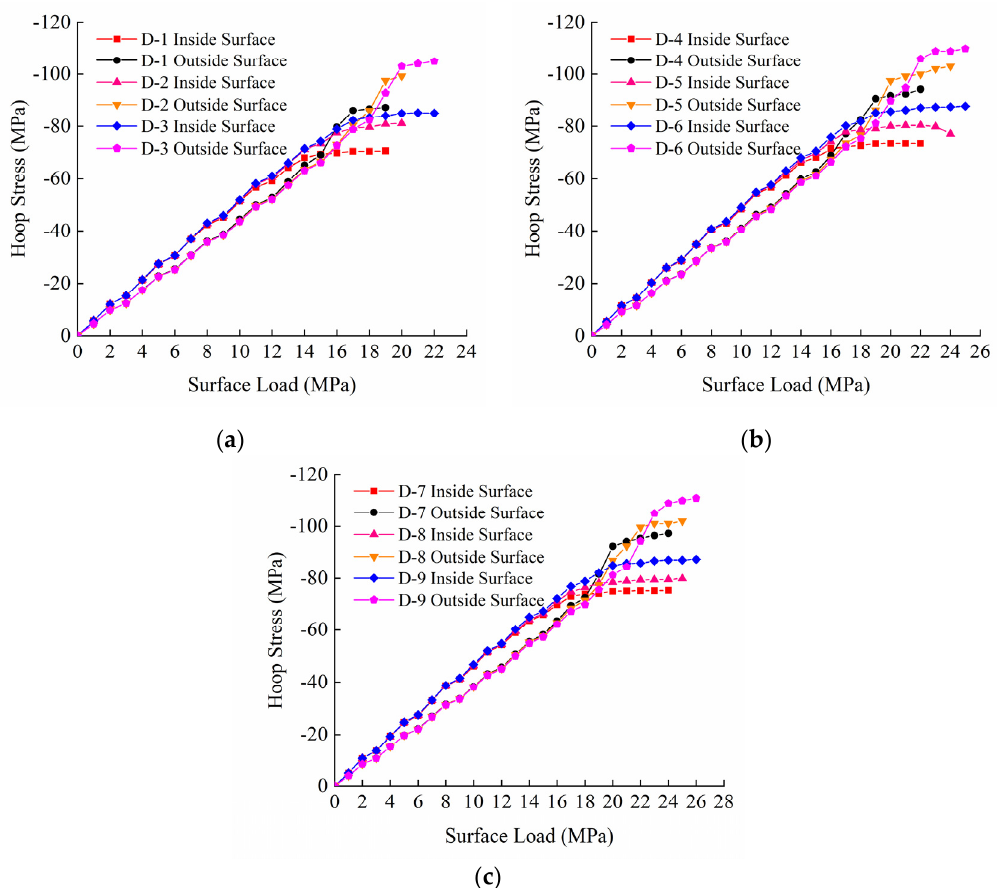
Figure 6. Relationship between hoop stresses and surface loads of shaft lining: ( a ) D-1~3 (shaft thickness 97.6 mm); ( b ) D-4~6 (shaft thickness 104.2 mm); ( c ) D-7~9 (shaft thickness 110.5 mm).